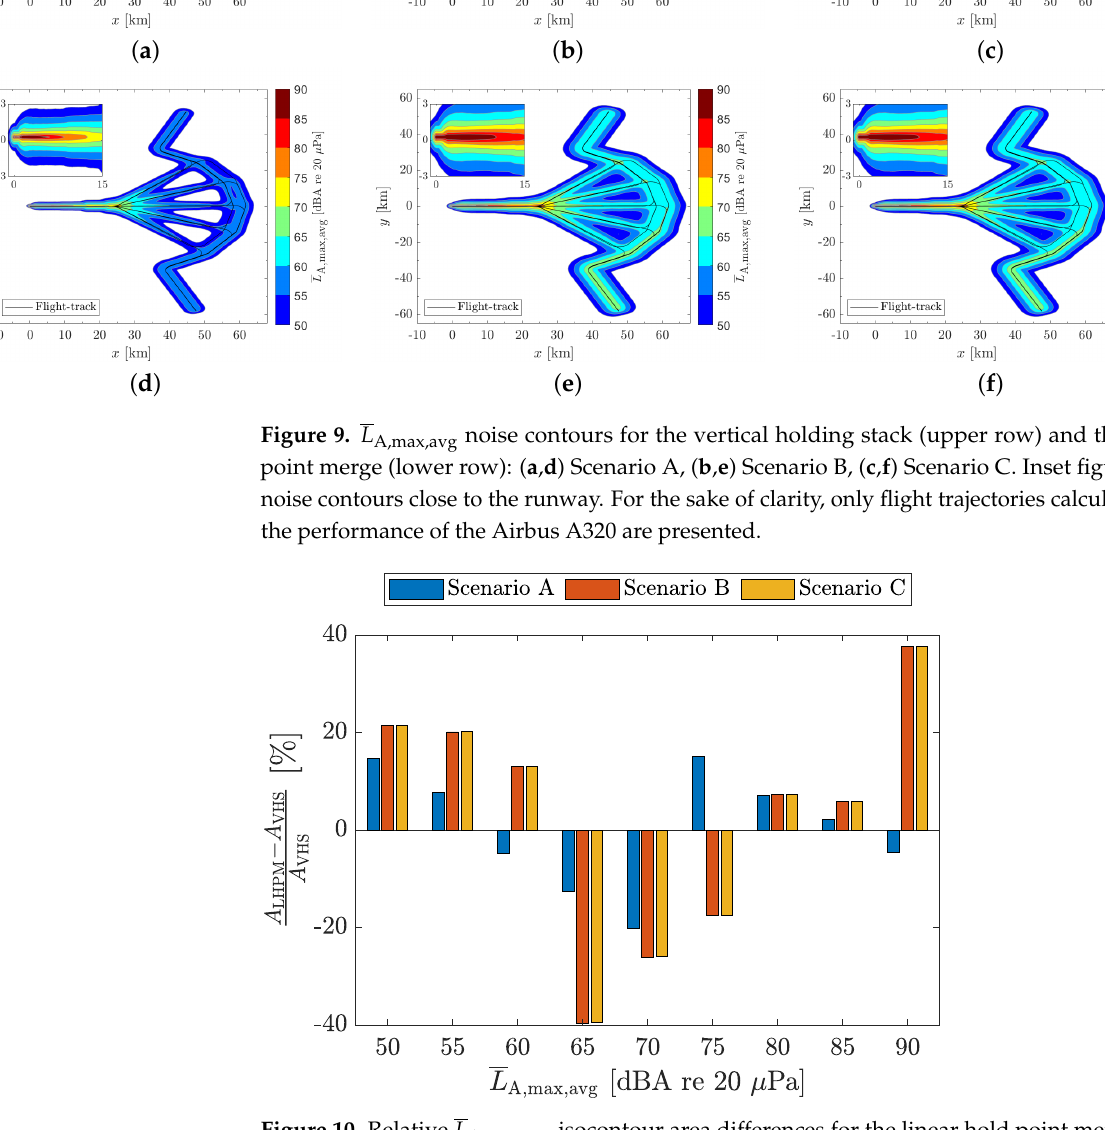
Figure 10. Relative L A,max,avg isocontour area differences for the linear hold point merge procedure with respect to the vertical holding stack